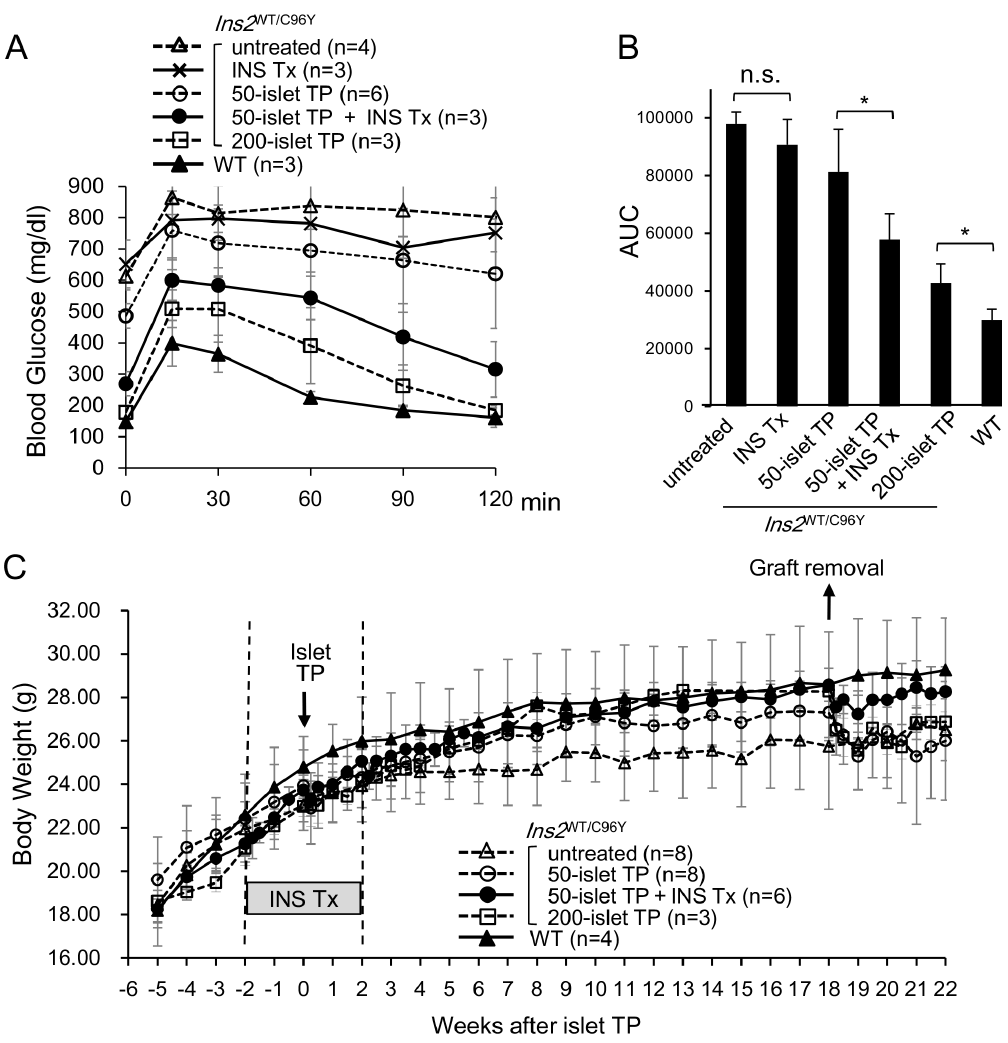
Figure 3. Glucose tolerance test of mice receiving 50-islet transplantation with insulin treatment showed improvment compared to those without insulin treatment. (A) An IPGTT was performed 9 weeks after transplantation. Blood glucose was measured 0, 30, 60, 90, and 120 min after glucose challenge. Blood glucose . 900 mg/dL was recorded as ‘‘high’’ and plotted as 900 mg/dL. (B) Areas under the curve for each graph in (A). A significant difference was observed between mice that underwent 50-islet transplantation with and without insulin treatment (* p , 0.05, two-tailed unpaired Student’s t- test). n. s., not significant. (C) Changes in the average body weight of each group.